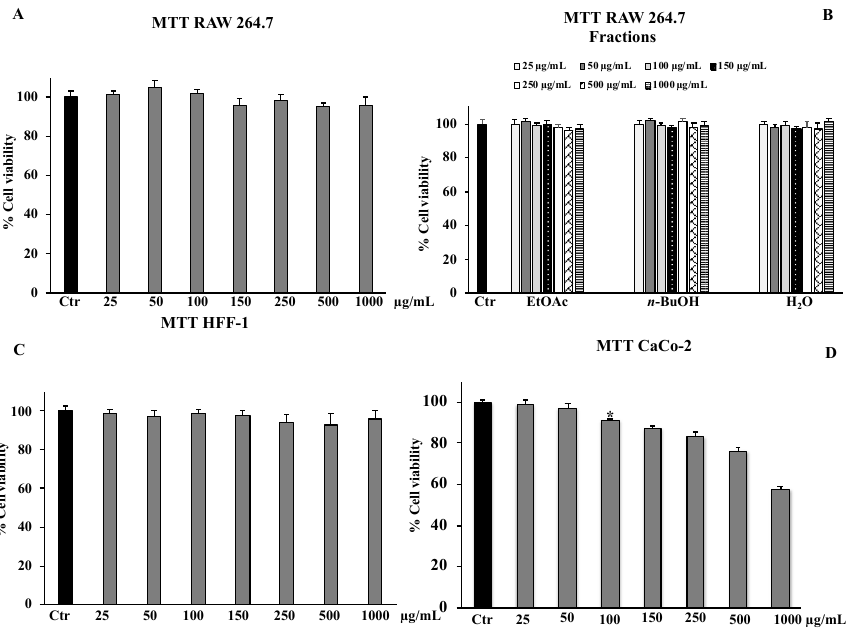
Figure 3. Cell viability in RAW 264.7 ( A , B ), HFF-1 ( C ), and CaCo-2 ( D ) cells untreated (Ctr) and treated for 24 h with the total extract or fractions (EtOAc, n -BuOH, or H 2 O). Values are the mean ± S.D. of five experiments in triplicate. Confidence intervals calculated by two-way